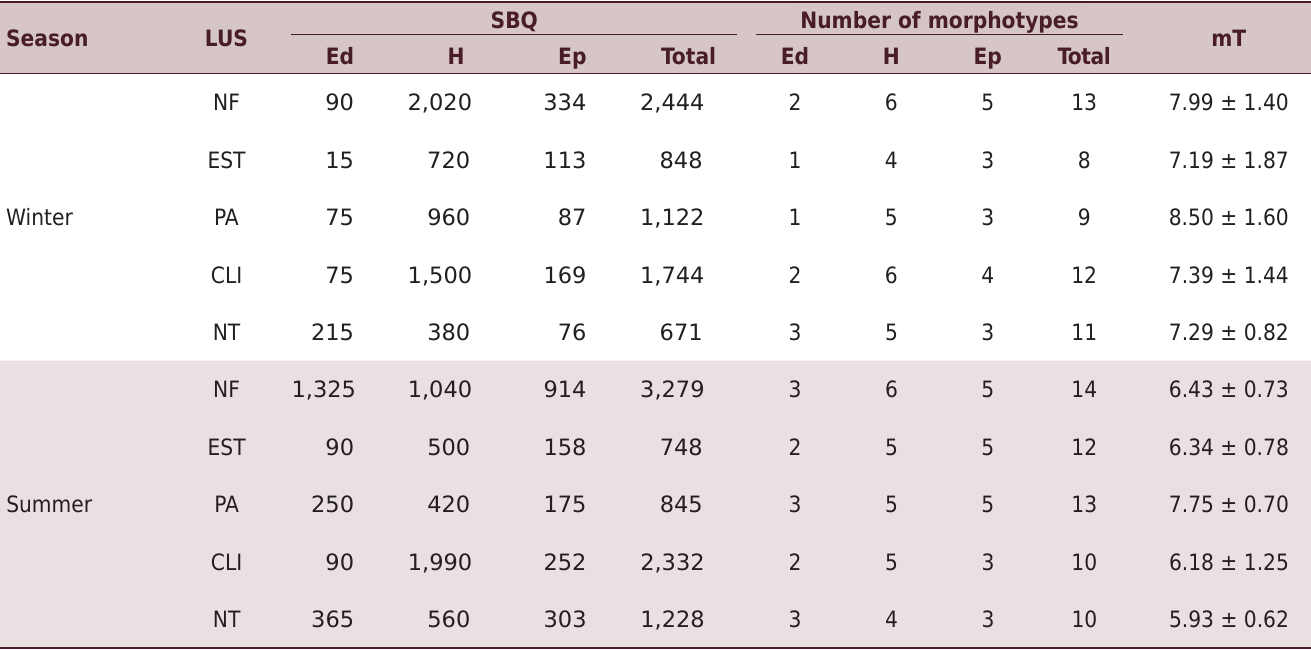
LUS: land use systems; SBQ: soil biological quality; Ed: edaphic; H: hemi-edaphic; Ep: epigean; and mT: mean value of the community trait.